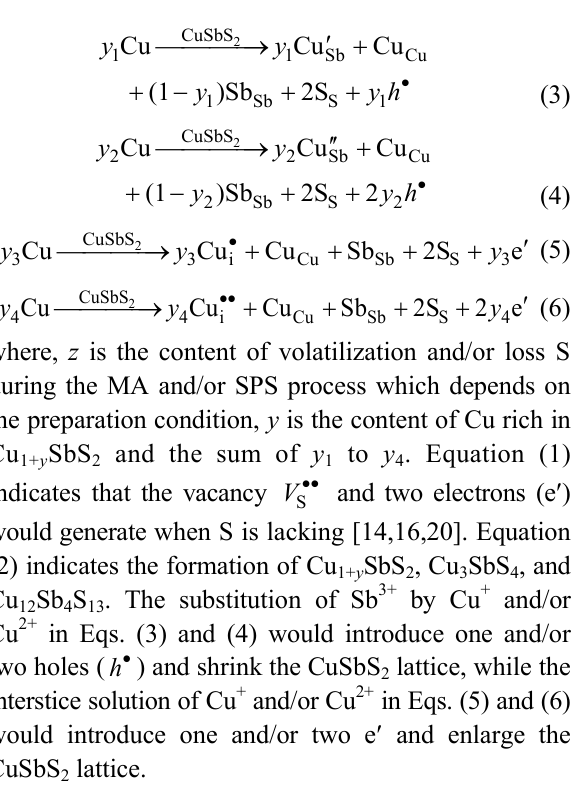
SbS , Cu SbS , and 1+ y 2 3 4